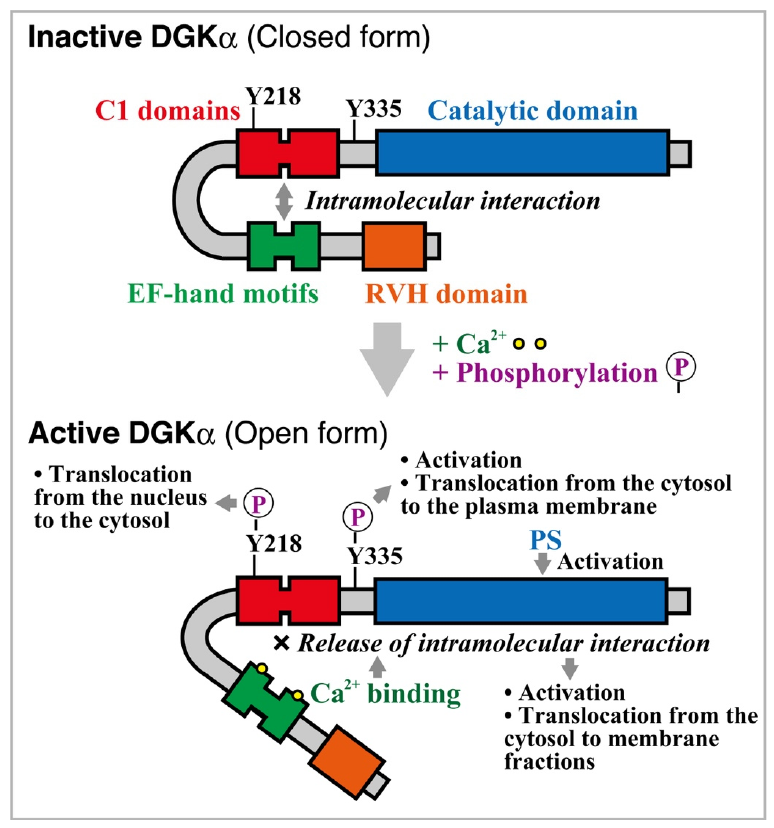
Figure 1. Structure and activation mechanisms of DGK α . DGK α has a recoverin homology (RVH) domain, two Ca 2+ -binding EF-hand motifs, two C1 domains, and a catalytic domain. Ca 2+ -dependent detachment of the intramolecular interaction between the EF-hand motifs and the C1 domains is the crucial event that controls DGK α activity and subcellular localization (translocation from the cytosol to membrane fractions). Phosphatidylserine (PS) binds to the catalytic domain and enhances activity. Phosphorylation at Tyr-335 induces translocation from the cytosol to the plasma membrane and activation of DGK α . Phosphorylation at Tyr-218 induces translocation from the nucleus to the